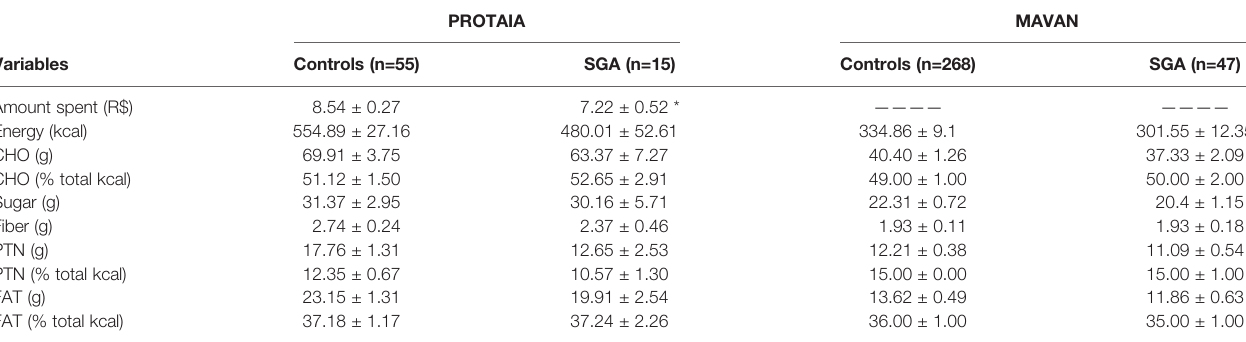
TABLE 2 | Food choice tests ’ data, according to birth weight for gestational age group.